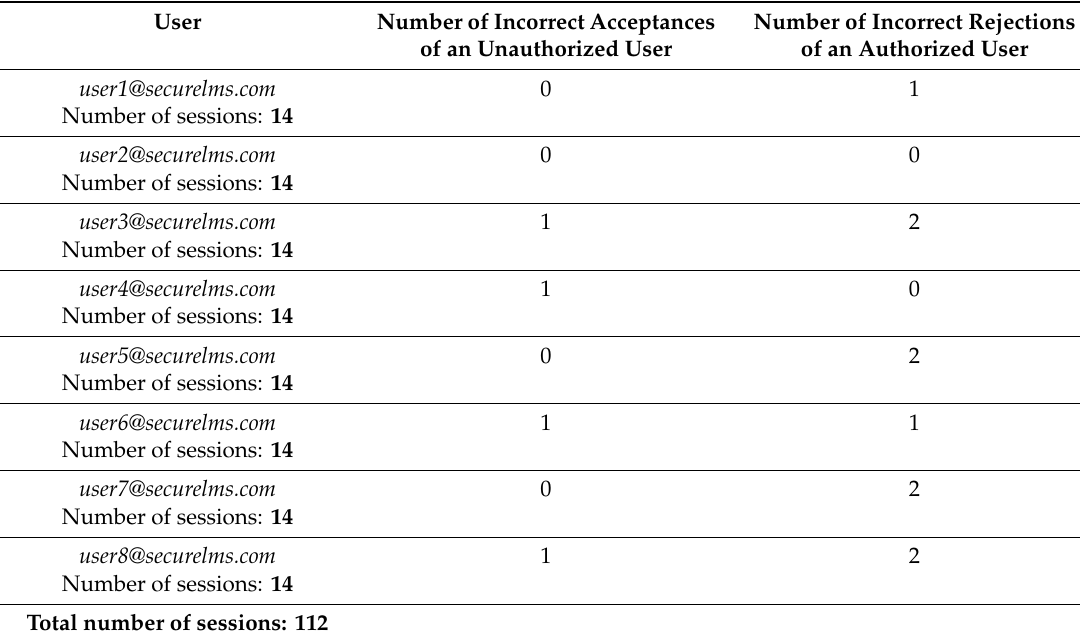
Table 4. The accuracy of continuous